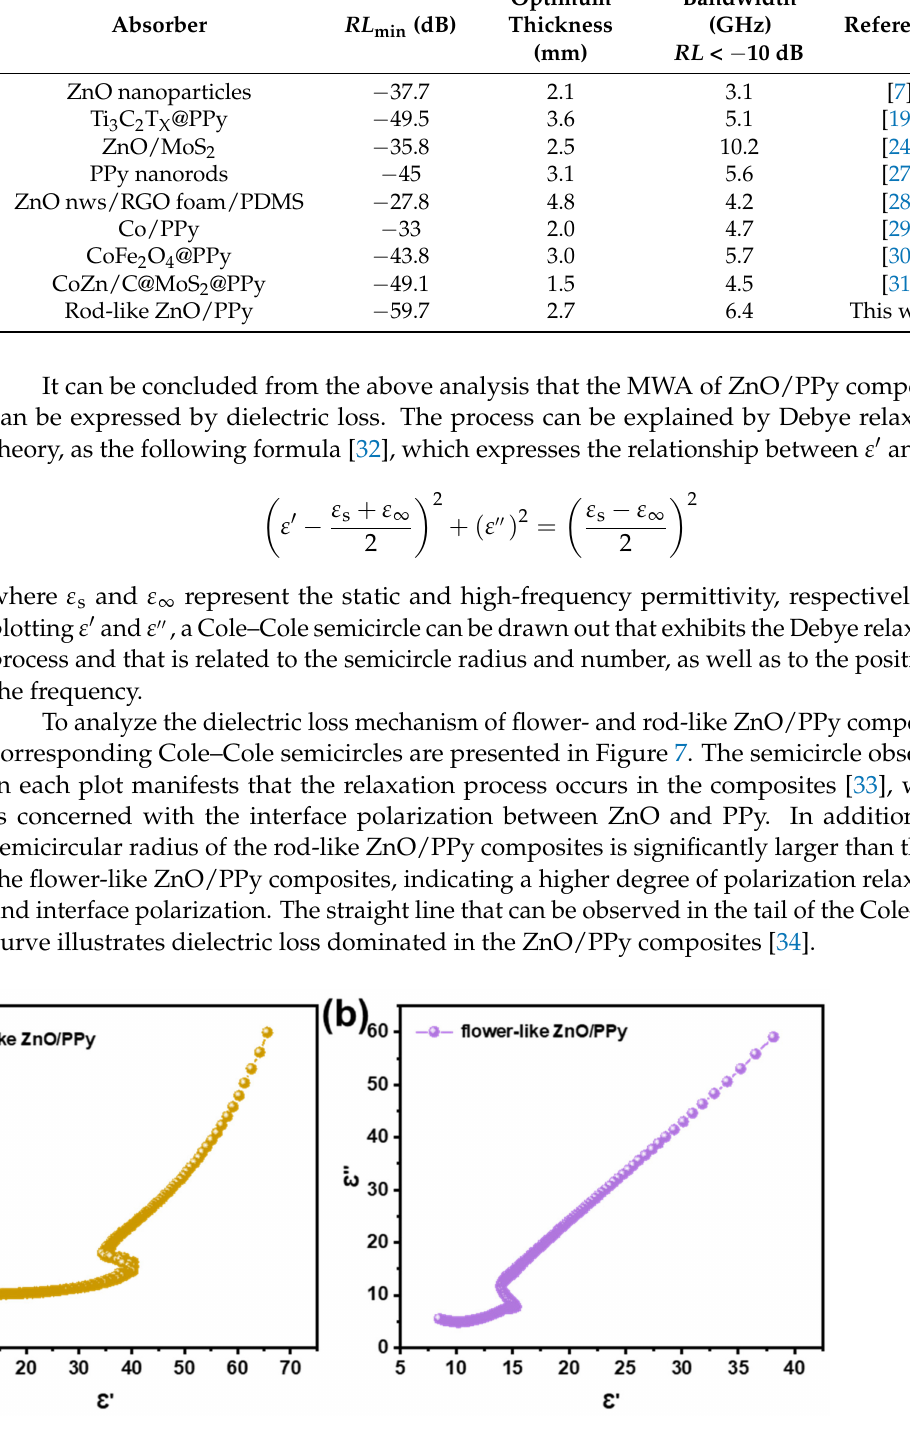
Figure 7. Cole–Cole semicircles of the composites: ( a ) flower-like ZnO/PPy, ( b ) rod-like